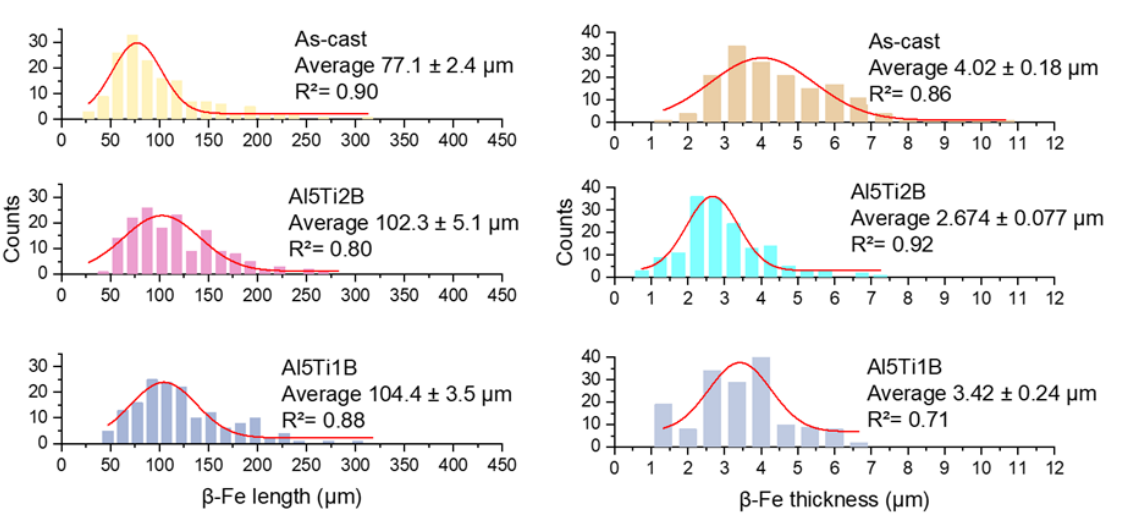
Figure 6. Length and thickness of the intermetallic beta iron (Al5FeSi).